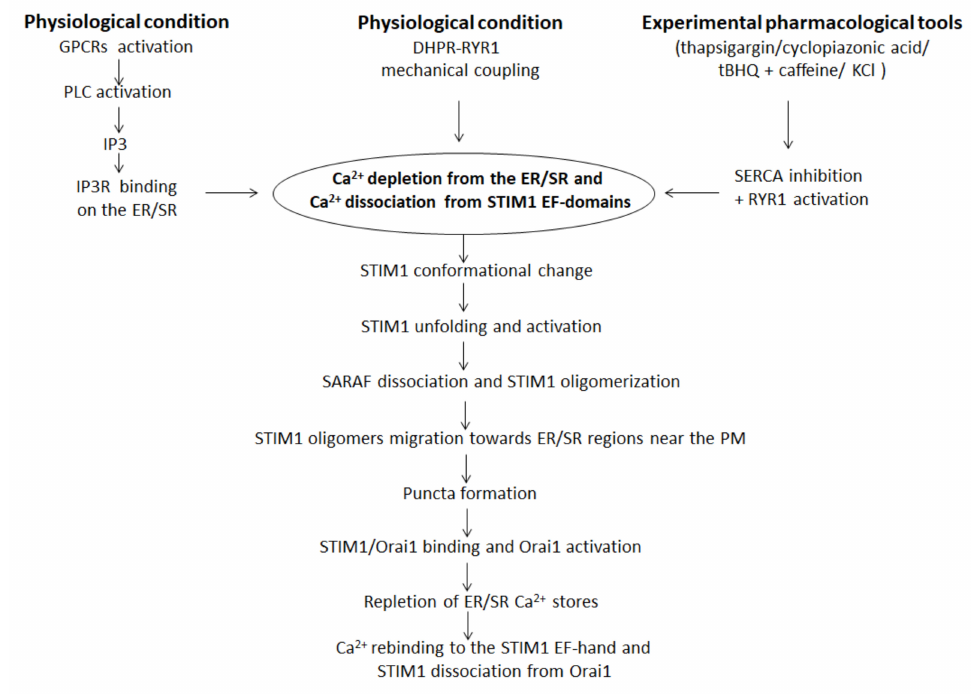
Figure 4. Schematic mechanism of the SOCE pathway. ER—endoplasmic reticulum; SR—sarcoplasmic reticulum; PM—plasma membrane; tBHQ—2,5-di-(tert-butyl)-1,4-benzohydroquinone; SERCA—sarco- /endoplasmic reticular calcium ATPase; RyR1—ryanodine receptor type 1; KCl—potassium chloride; GPCRs—plasma membrane G-protein-coupled receptors; PLC—phospholipase C; IP3—inositol 1,4,5- triphosphate; STIM1—stromal interaction molecule